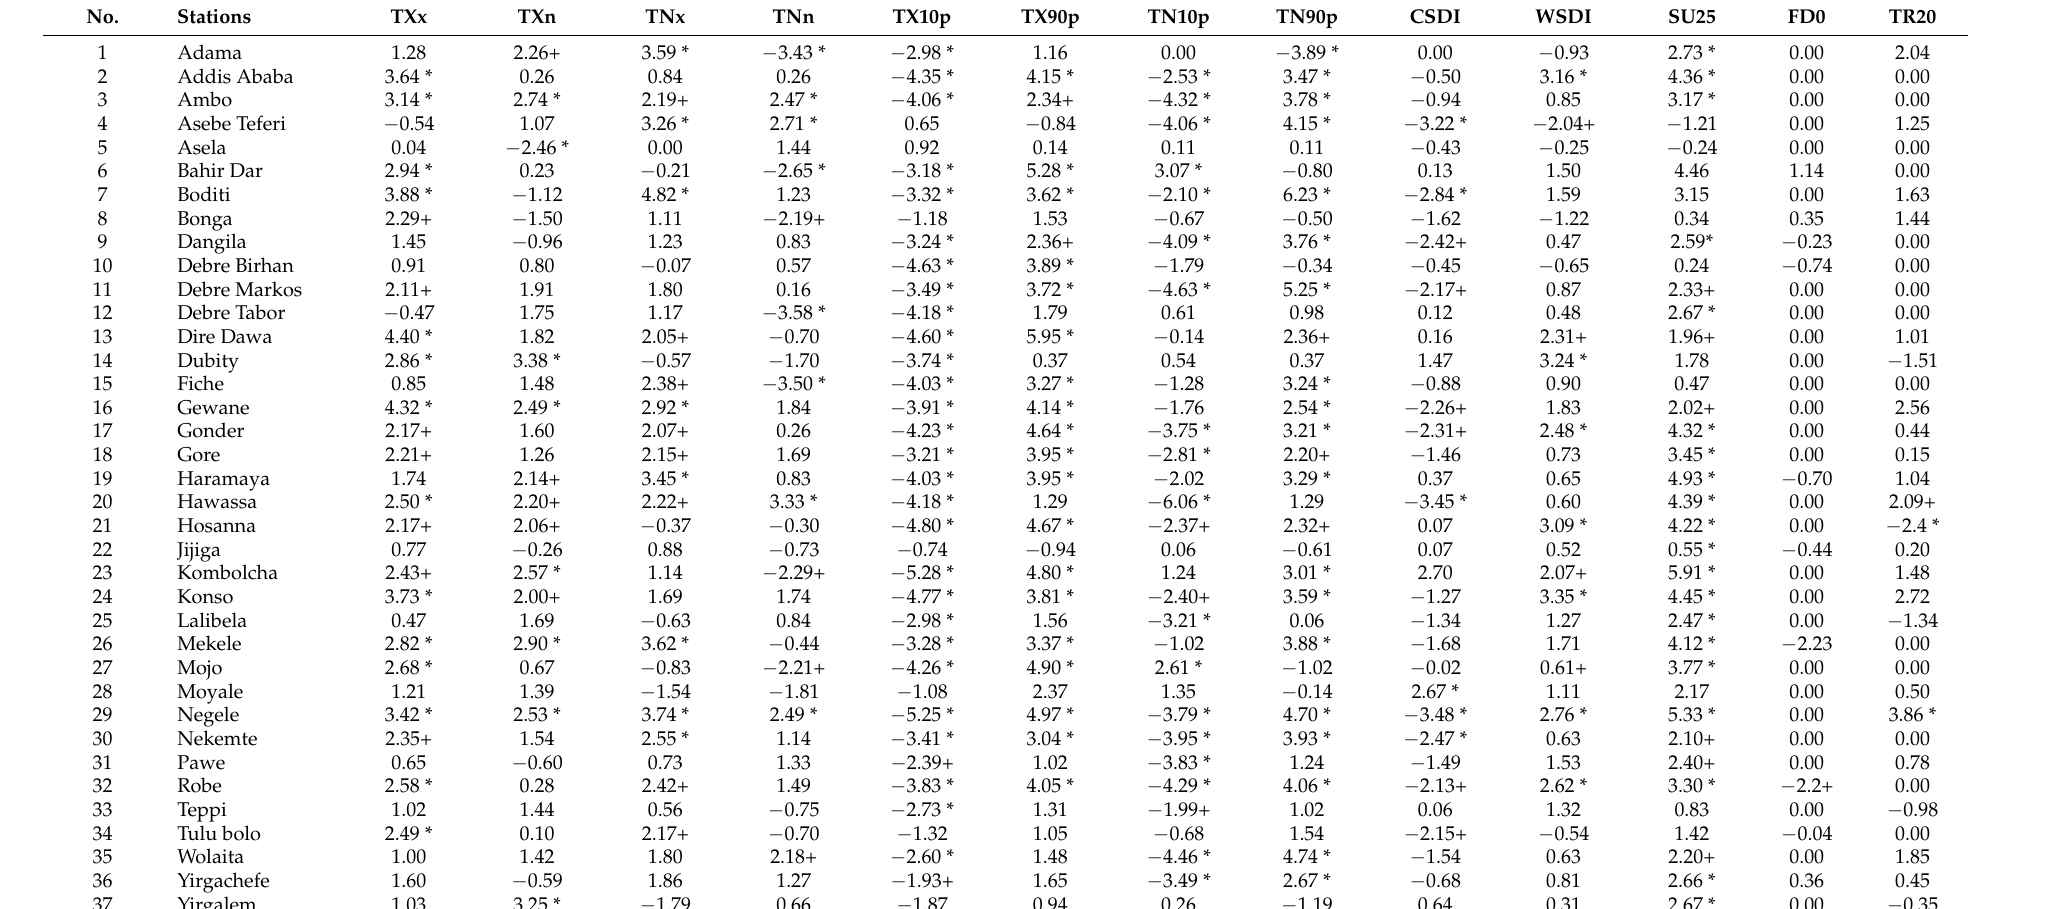
Table 6. Results of the trend analysis of extreme temperature indices in